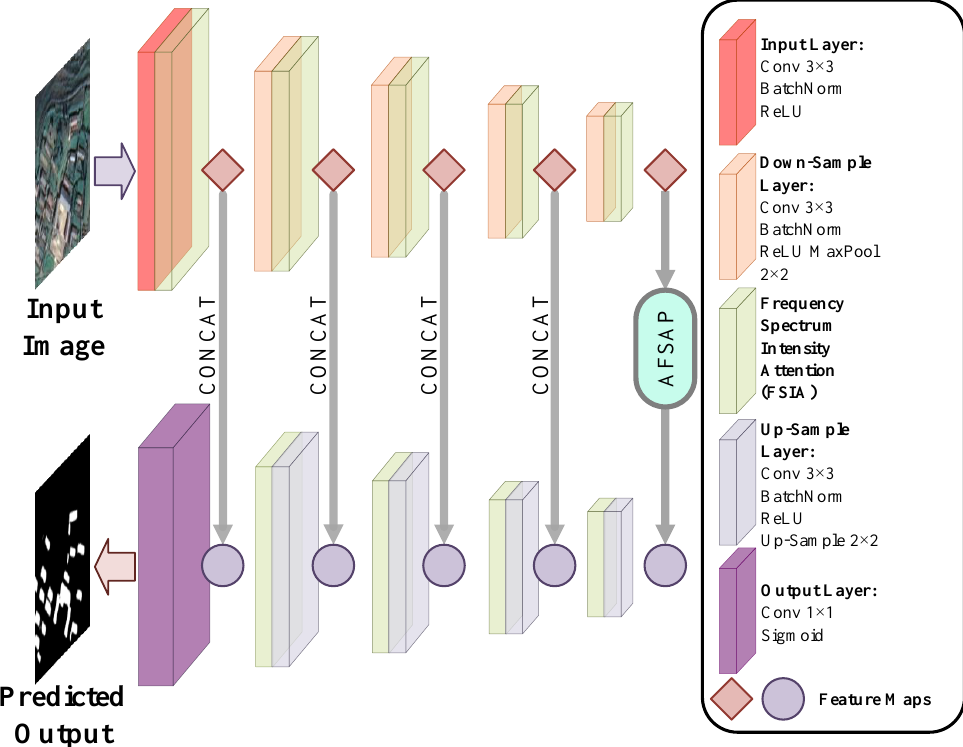
Figure 1. The brief procedure of the proposed FSIANet. The AFSAP indicates the proposed atrous frequency spectrum attention